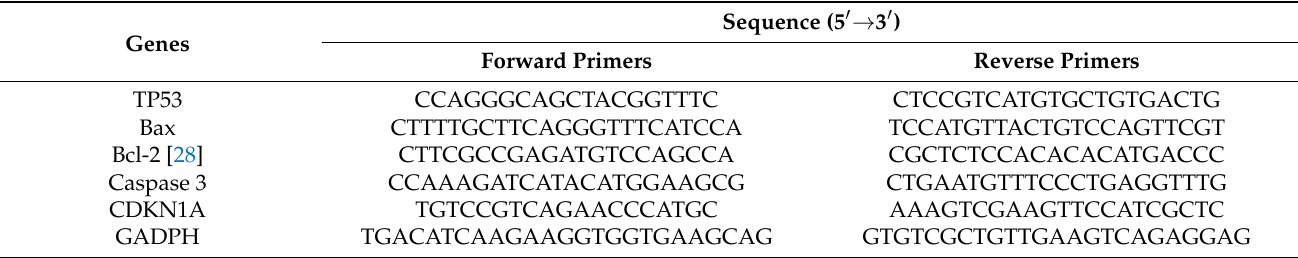
Table 1. Gene-specific primers used in the